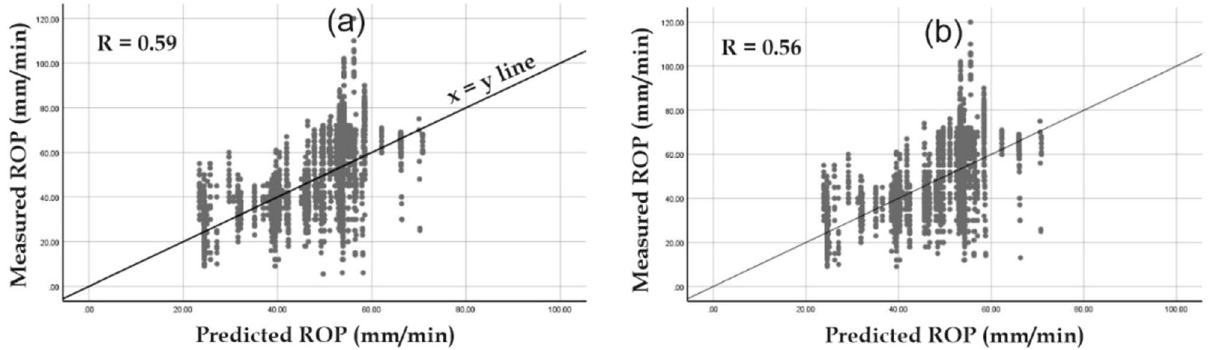
Fig. 7 Cross-correlation graphs between predicted and measured ROPs; a model 1 and b model 2